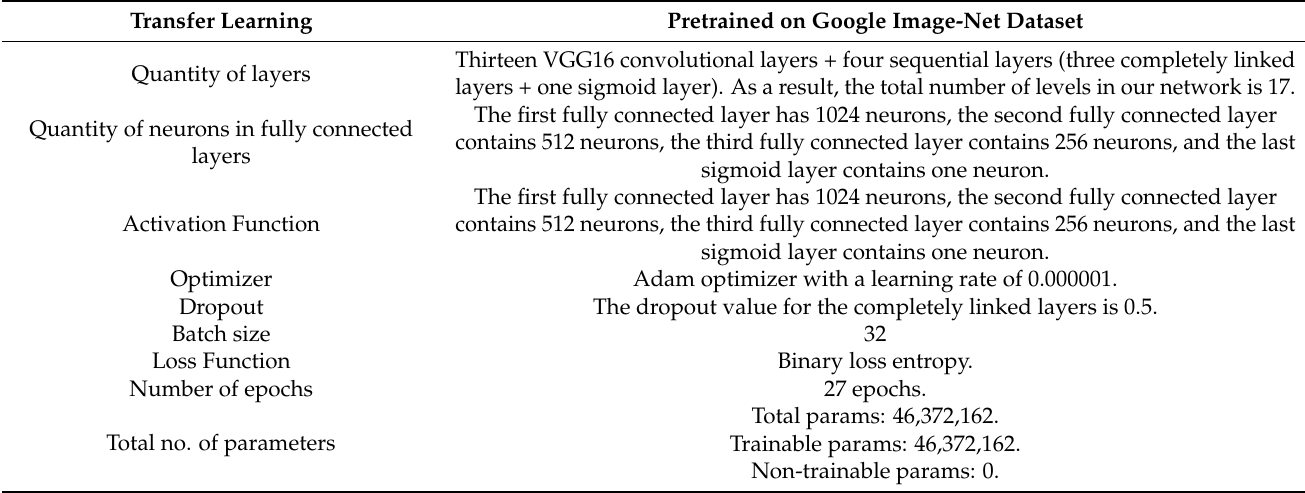
Table 1. Summary of the modified VGG16 model .